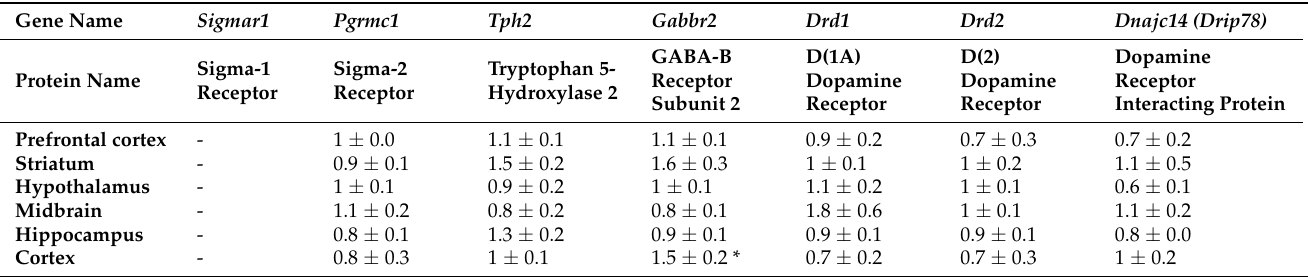
Table 1. Gene expression in adult Sig1R KO mice